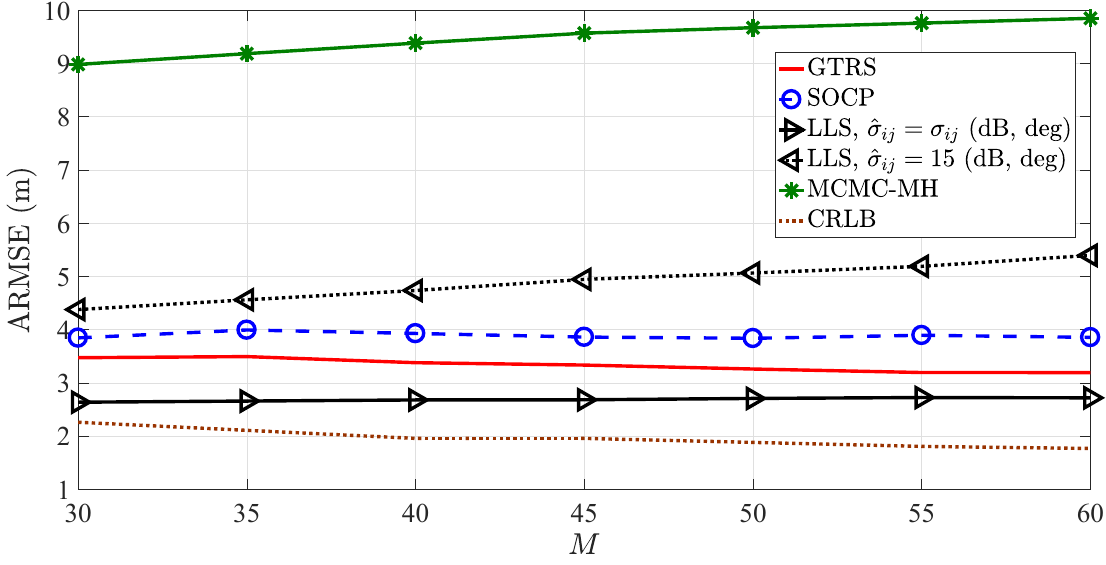
Figure 13. ARMSE (m) versus M : N = 15, R = 10 m, M c =